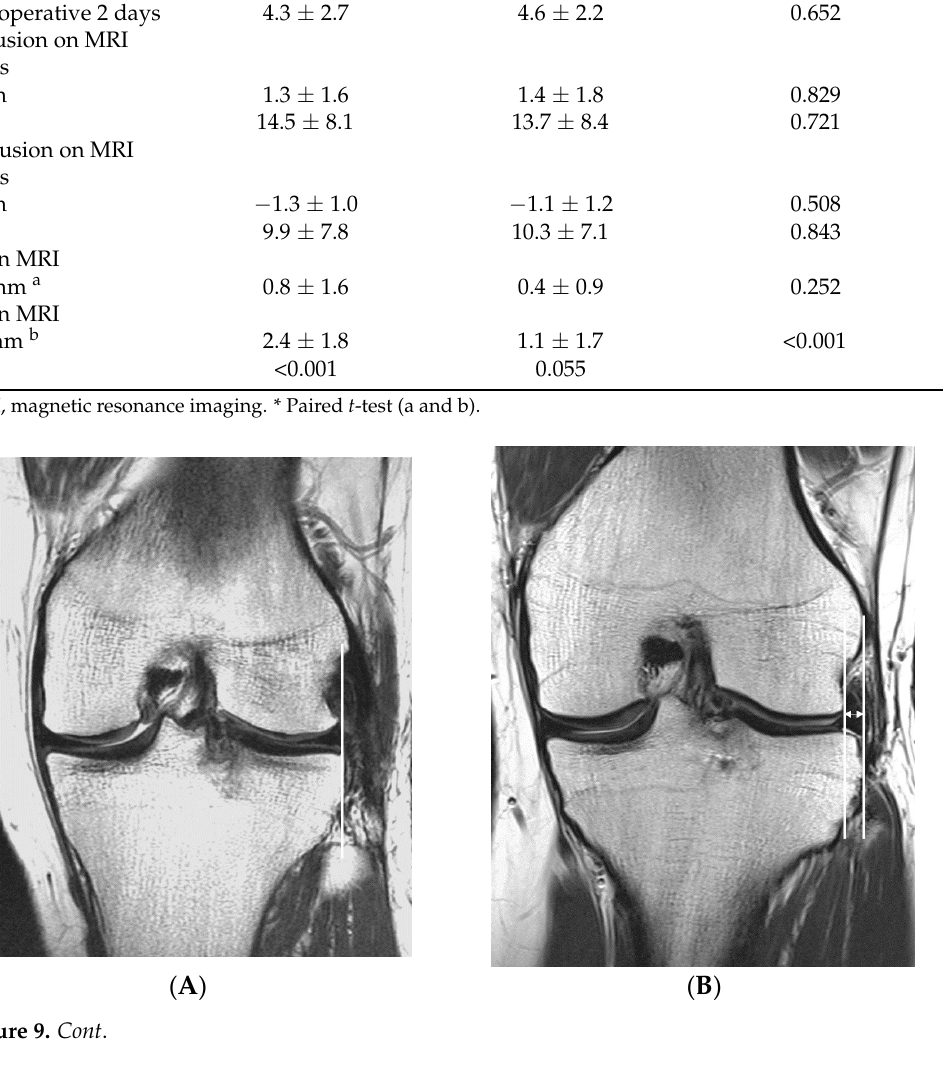
( D ) Figure 9. ( A ) Postoperative magnetic resonance image (MRI) at 2 days after lateral meniscal allograft transplantation (MAT) and ( B ) postoperative MRI at 1 year after the surgery in the patient who performed isolated lateral MAT. Graft extrusion increased from 0mm to 2.9mm. ( C ) Postoperative MRI at 2 days after lateral MAT and ( B ) postoperative MRI at 1 year after the surgery in the patient who performed lateral MAT + capsulodesis. Graft extrusion was not found until 1 year after the surgery. Table 2. Graft extrusion.